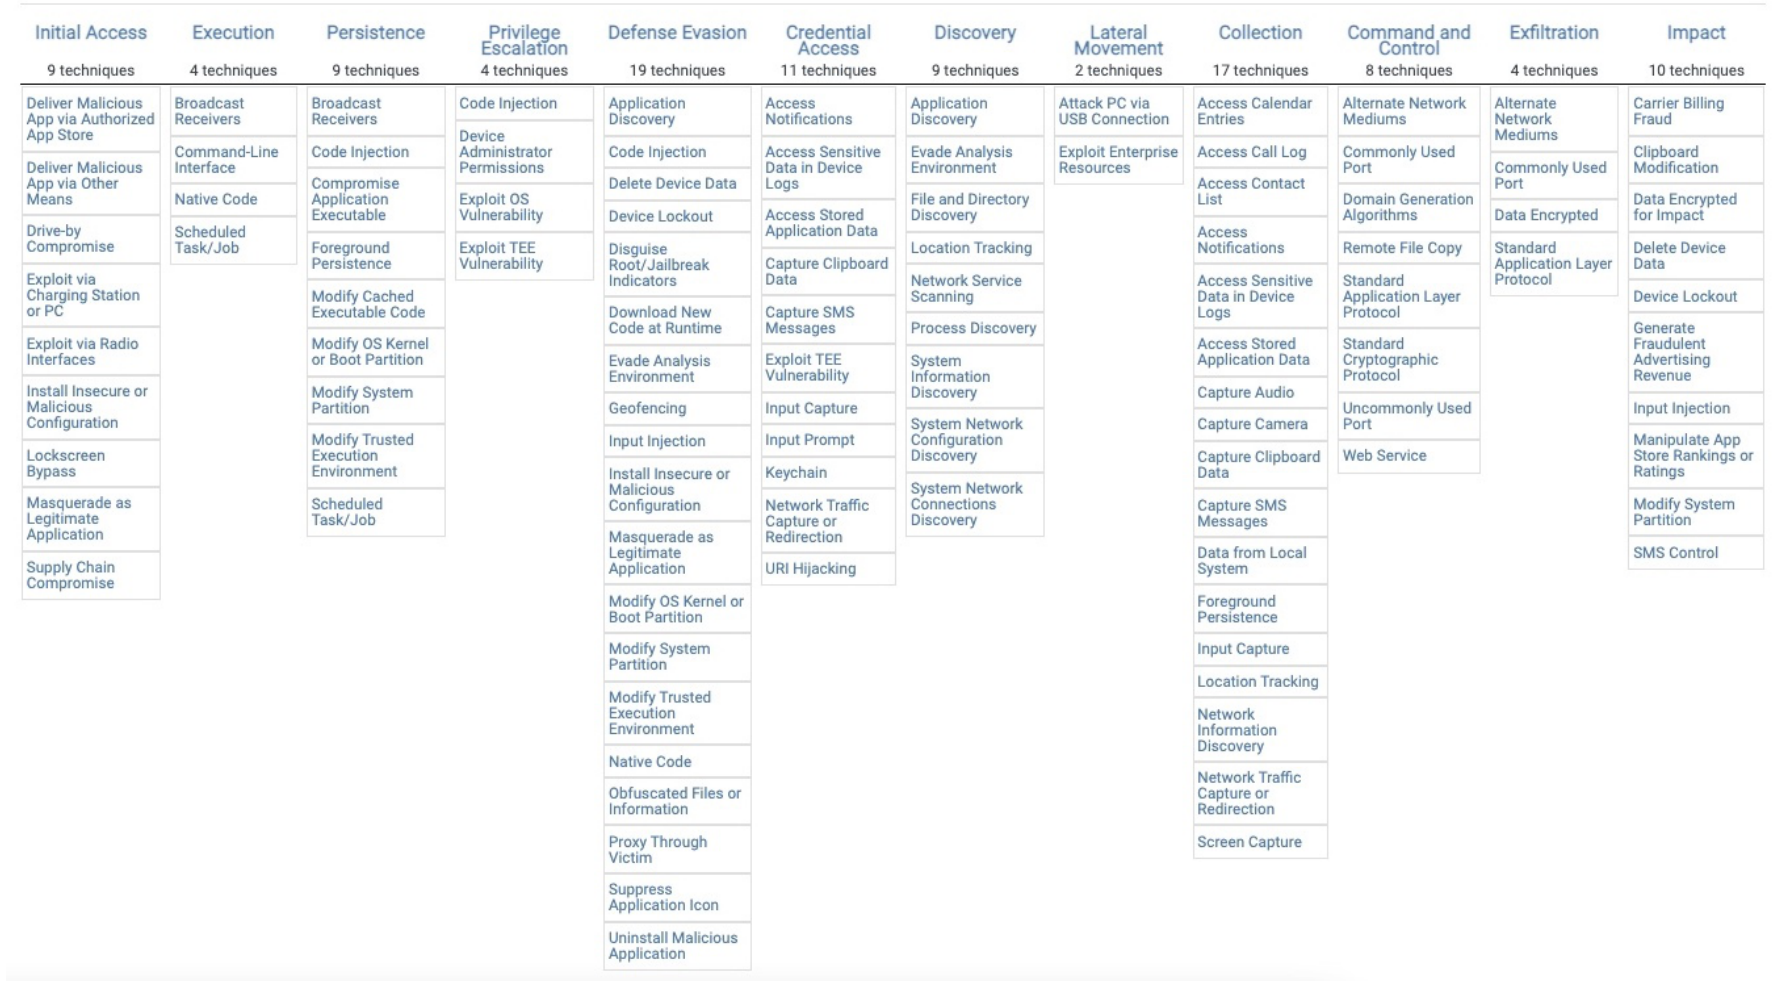
Figure A1. The ATT&CK matrix for the mobile OS consists of two parts. The first part of the matrix covers the device